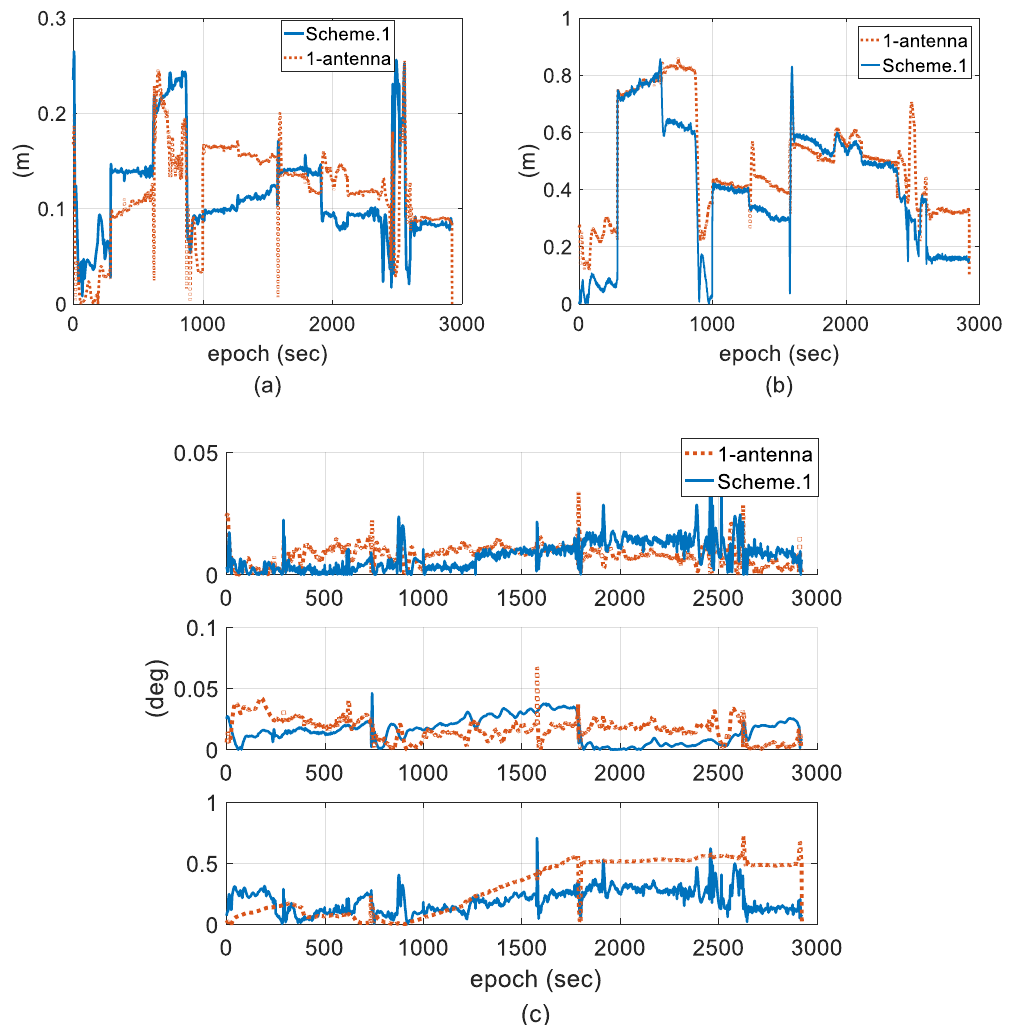
Figure 15. Error comparison of the one-antenna integration and the two-antenna integration using EKF. ( a ) Horizontal position; ( b ) vertical position; and ( c ) attitude.